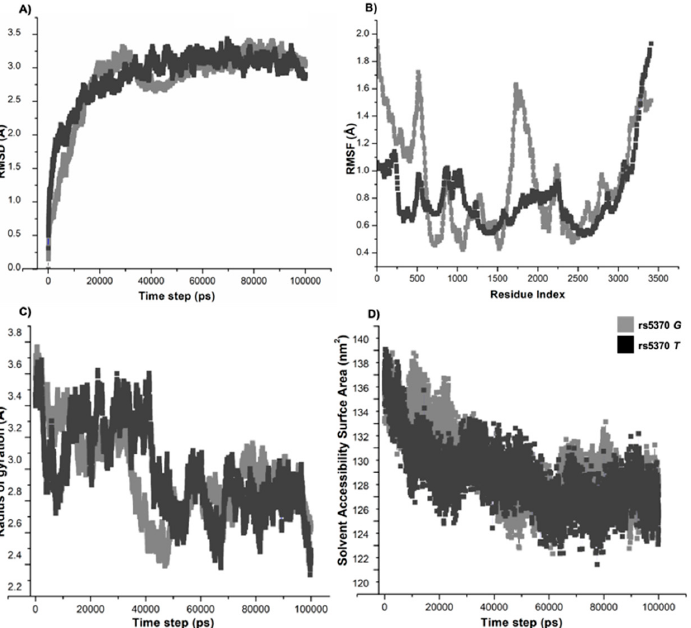
Figure 4. Structural dynamics of ppET-1 for rs5370 alleles. ( A ) RMSD, the molecular dynamics simulation for the wild-type system shows a gradual increase in the RMSD value with more fluctuations compared to variant allele. ( B ) RMSF; the wild-type residue’s fluctuation level was higher than the variant residue’s fluctuation. ( C ) Rg values and variant allele depicted structural stabilizing effects with higher gyration values when compared to the wild type. ( D ) SASA values, the wild type represented higher SASA values as compared to the variant allele. The ordinate is RMSD (Å), and the abscissa is time (ps). Light grey and dark grey indicate wild and variant residues, respectively. Å, Angstrom; nm 2 , nanometre square; ps, picosecond; Rg, radius of gyration.